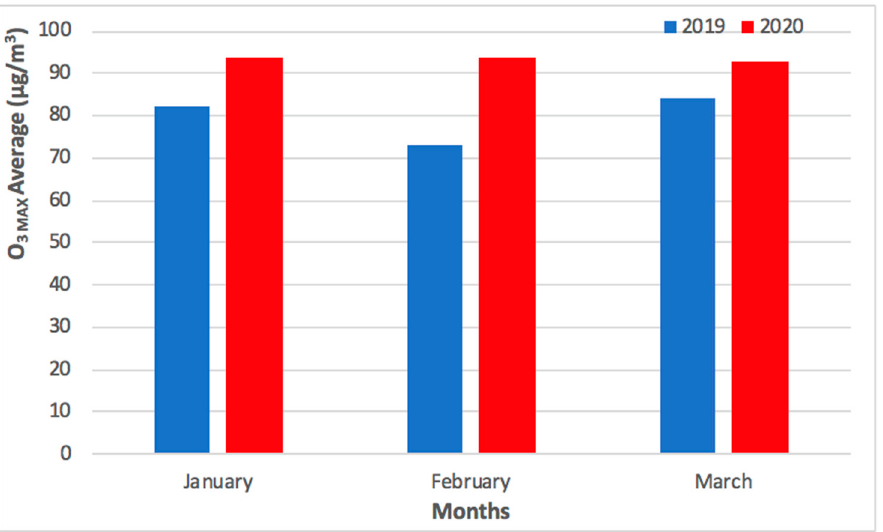
Figure 6. Monthly mean O 3 MAX concentrations for Taipa Ambient during the previous year of 2019 and COVID-19 pandemic in 2020 (January to March).